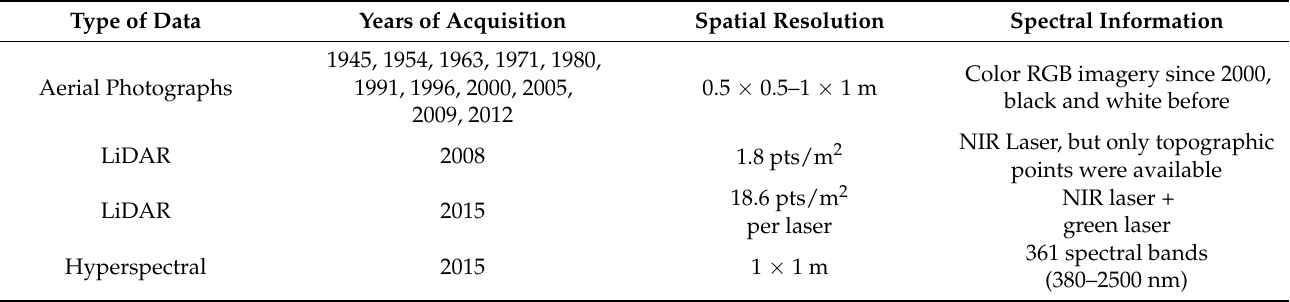
Table 2. Remote sensing datasets used in this